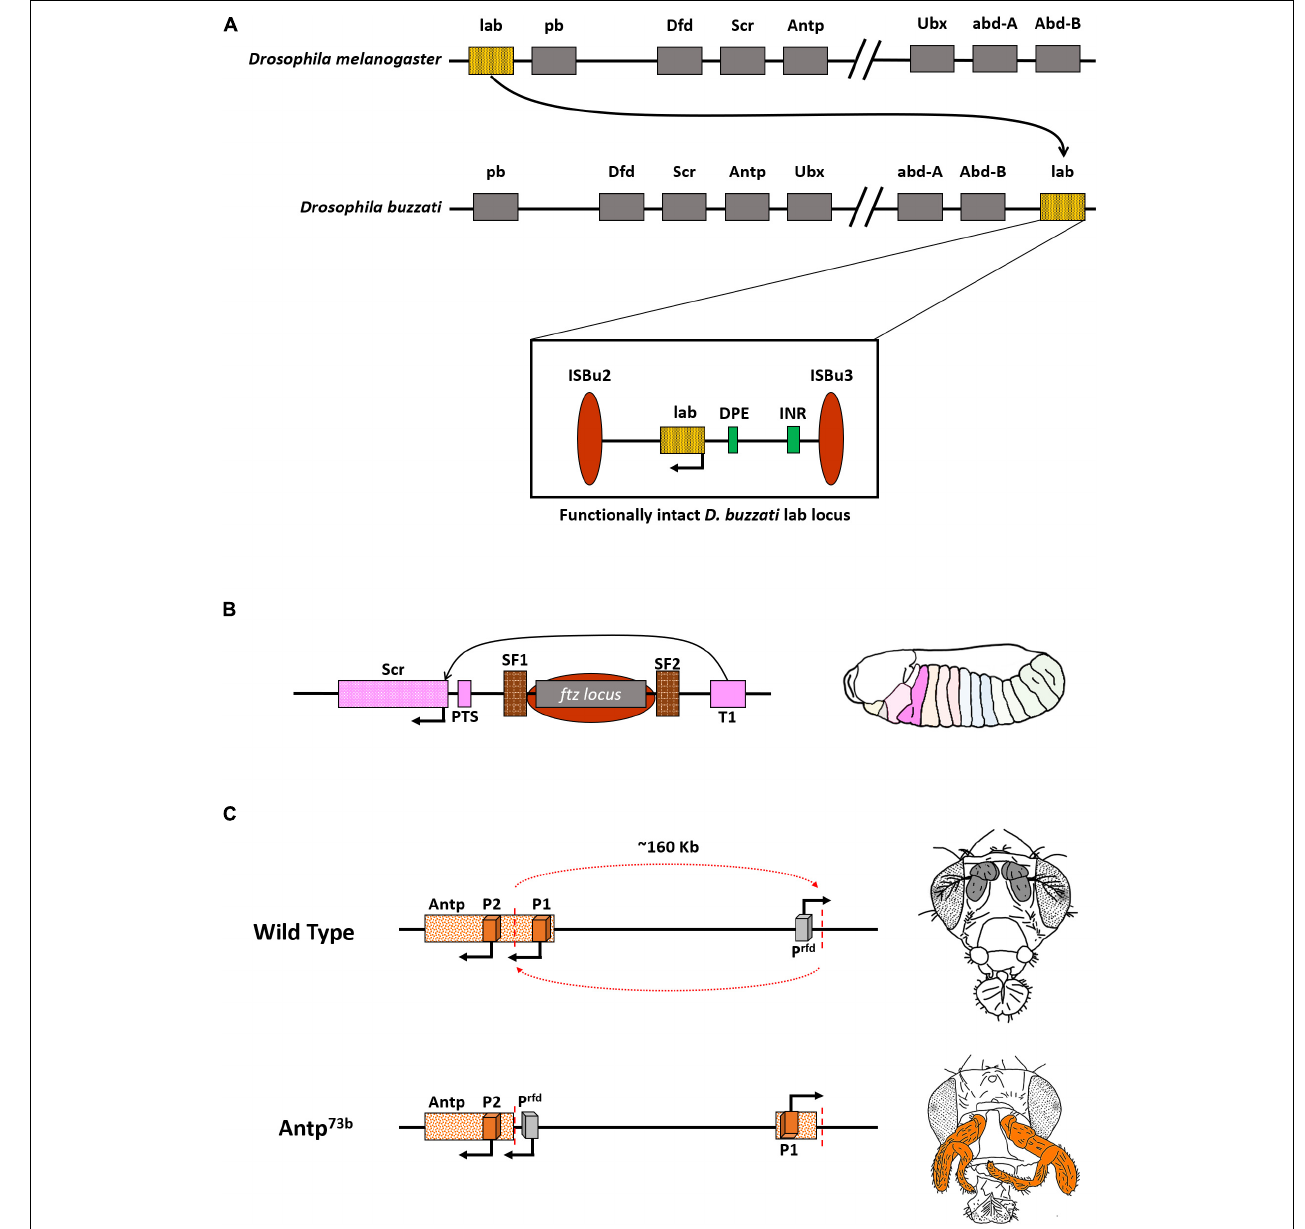
FIGURE 3 | Functional CRMs can accommodate changes in gene order. (A) Representation of Hox in D. melanogaster and D. buzzati . Note that the gene labial ( lab ) is present next to Abdominal-B ( Abd-B ), and the split is between Ubx and abd-A, wherein Ubx is now a part of ANT-C. Inset: Functional intactness of lab locus despite rearrangement owing to two transposons, ISBu2/3, that flank the regulatory cassette of the gene. (B) Illustration depicting regulation of Scr gene bypassing ftz locus. The ftz gene and regulators are flanked by boundary elements SF1 and SF2. T1 is the enhancer for Scr. Right: Domain expression of Scr in a normal condition. (C) Inversion involving Antp ( Antp 73 b ) spanning ∼ 160 Kb juxtaposes the gene to an ectopic promoter that drives its expression in antennae and arista of the flies (colored bold gray in wild type fly). This leads to the homeotic transformation of antennae to legs (highlighted in